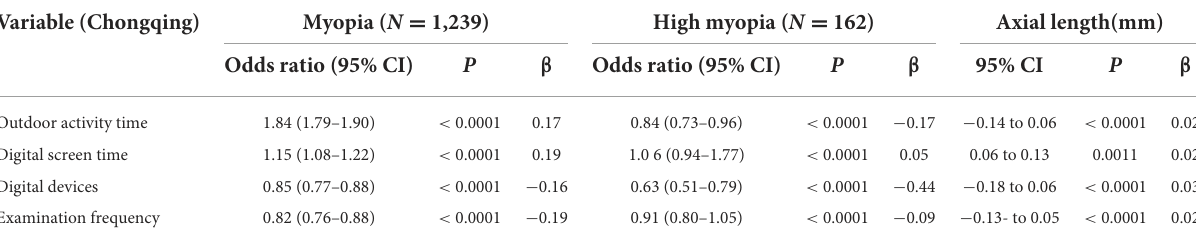
TABLE 3 Multivariate logistic regression results for myopia and high myopia in Chongqing. Variable (Chongqing)